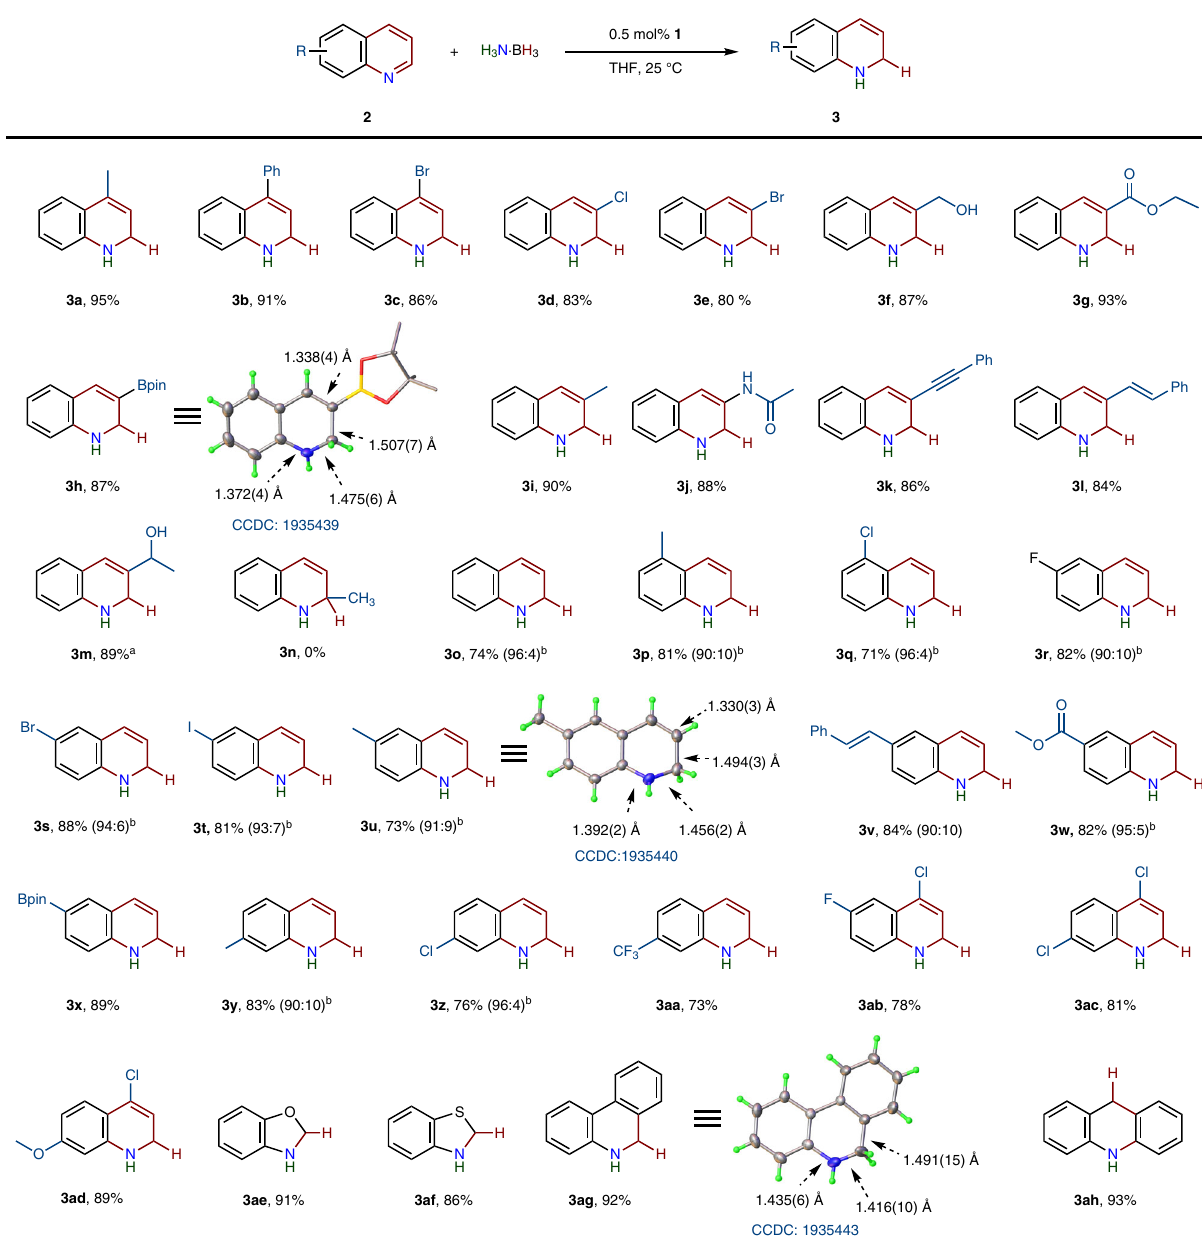
Fig. 2 Substrate scope. Reaction conditions: substrate (0.5 mmol), H 3 N ∙ BH 3 (0.55 mmol) and 1 (0.5 mol%) were stirred in THF (2 mL) at 25 o C for 20 h. Isolated yields are given. a Two equiv. of H 3 N·BH 3 (1 mmol) was used for reduction of 3-acetylquinoline. b Ratios in parentheses refer to product ratios of 1,2- DHQ and THQ determined by 1 H NMR